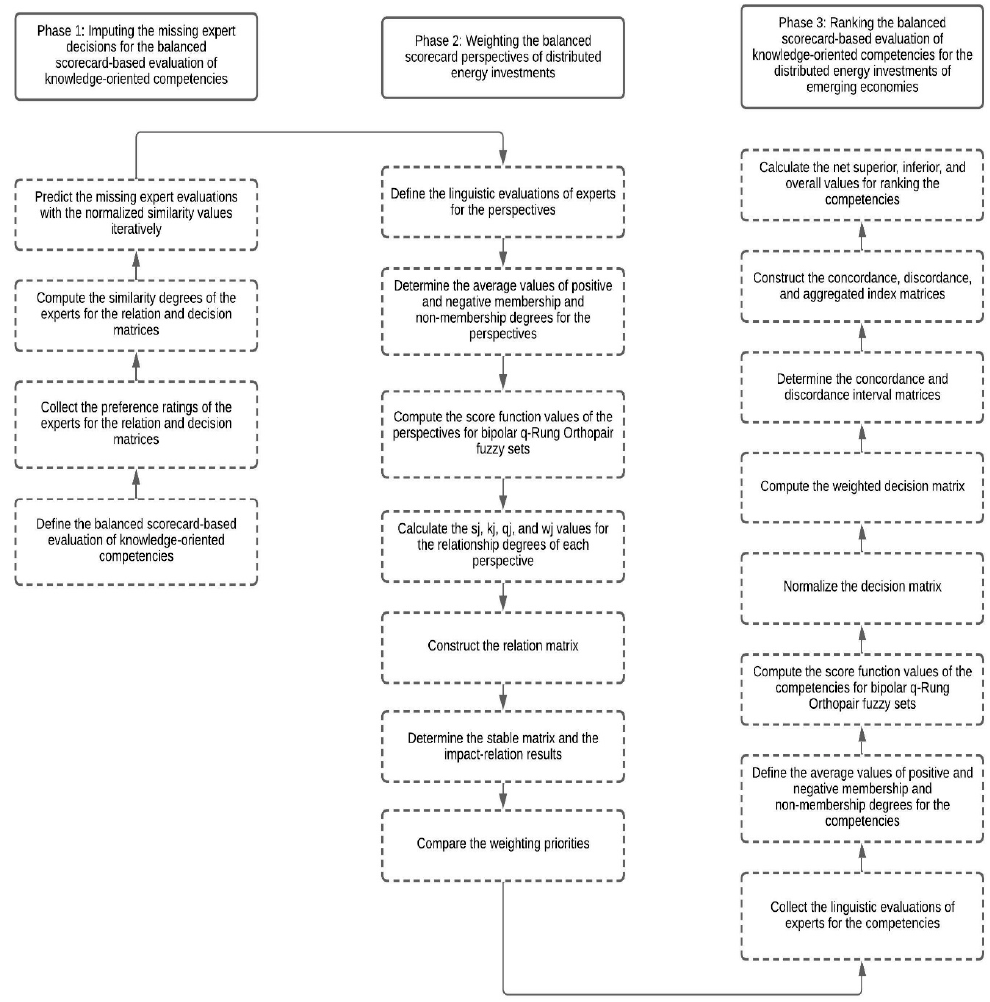
Figure 1. Flowchart. Table 1. Balanced scorecard perspectives for distributed energy investments.